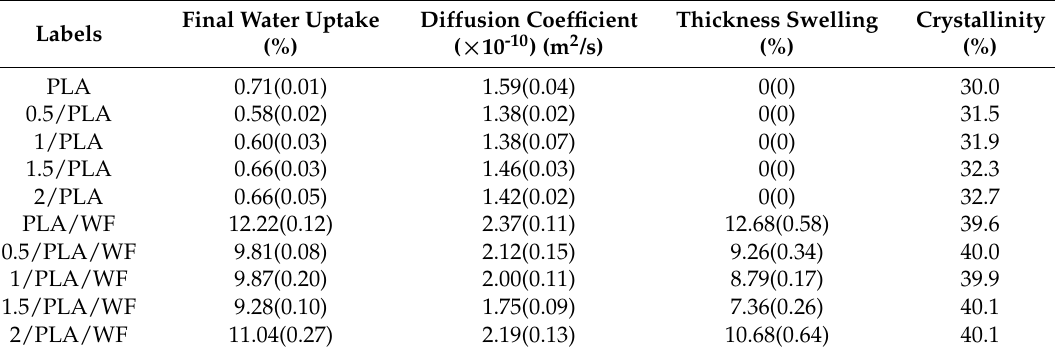
Table 2. Final water uptake, diffusion coefficient, thickness swelling, and crystallinity of virgin and OMMT-modified PLA and the composites.